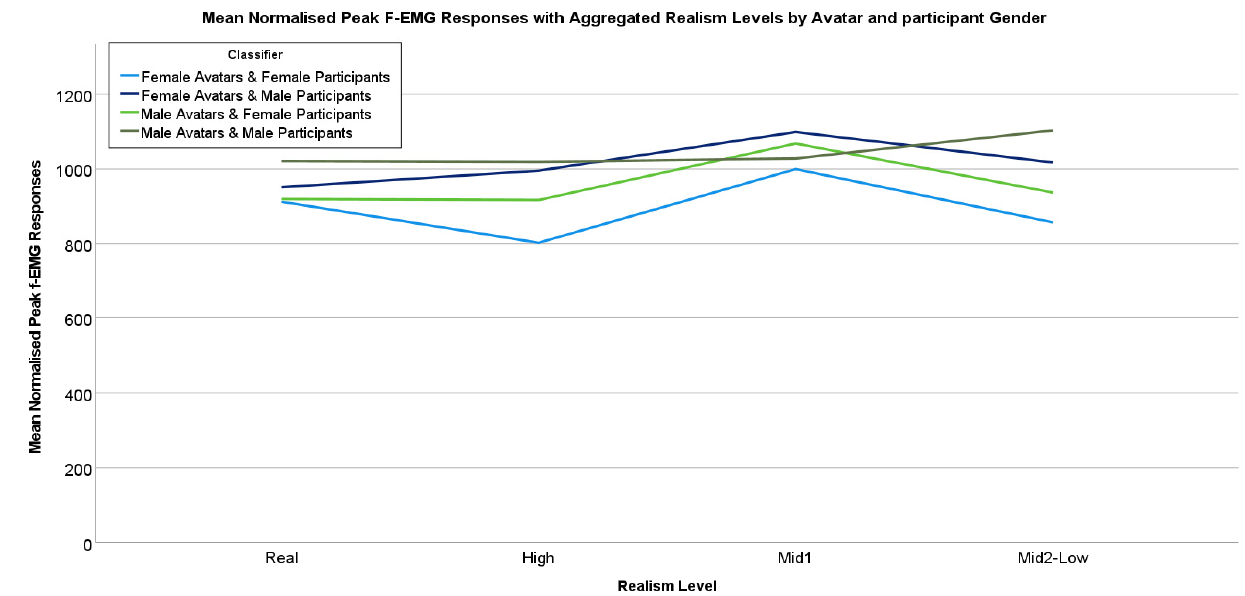
Figure 12. Mean normalized peak f-EMG responses for the realism levels by both avatar and participant gender(sex).